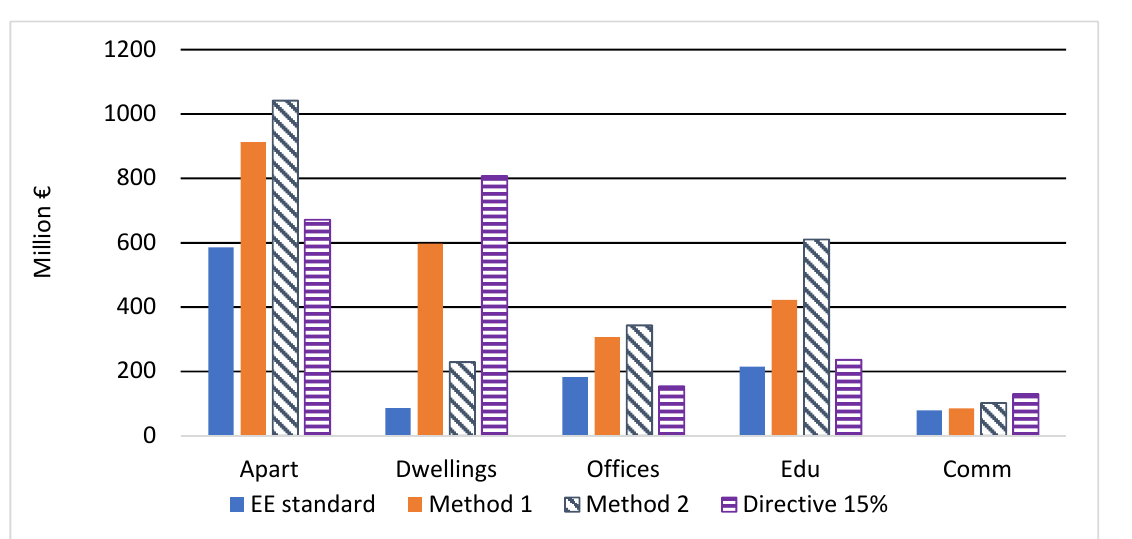
Figure 5 . Cost estimates to class E (EPBD) up to 2033, million euros. The percentage differences of renovation volumes between EPBD 2033 and the LTRS, the latter assuming a constant renovation rate to class C by 2050, are reported in Table 12 and visualised in Figure 6. Table 12 . Percentage difference in renovation volume, EPBD vs. the LTRS. Cat.